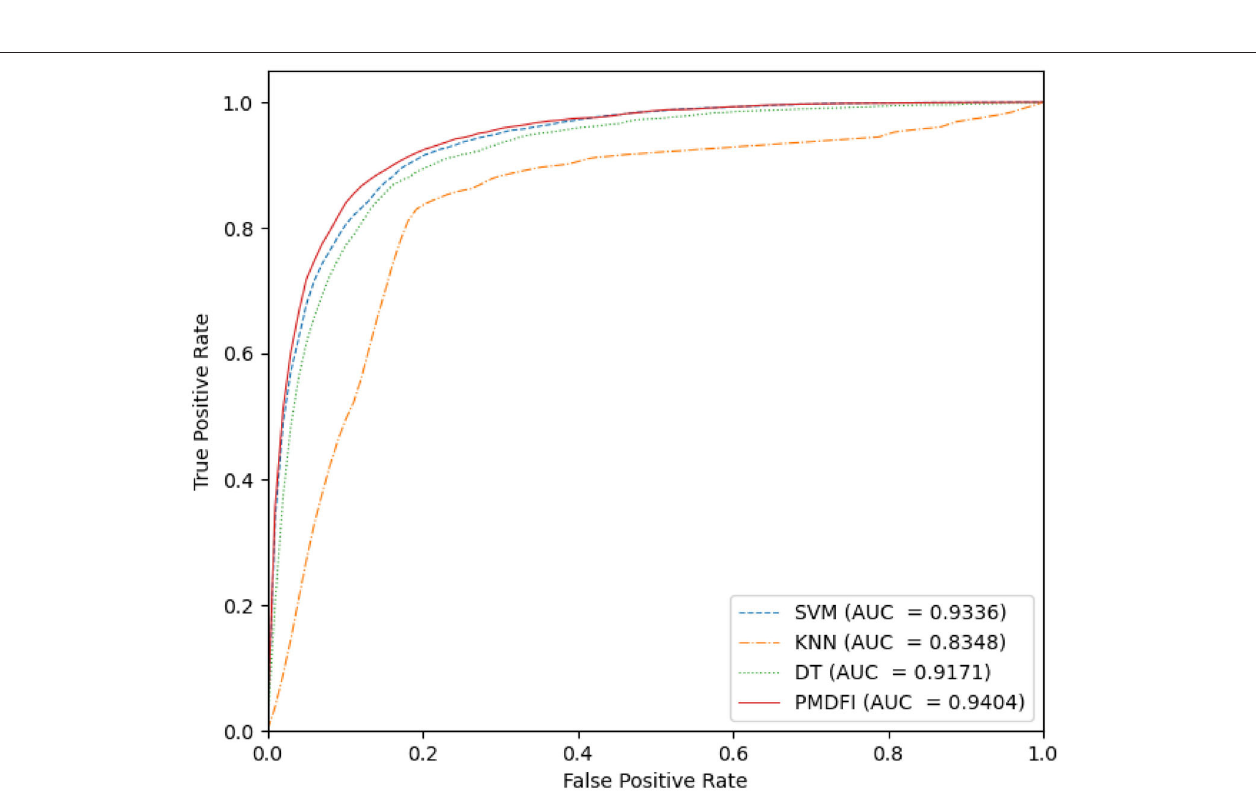
FIGURE 5 | The ROC curves of different classifier